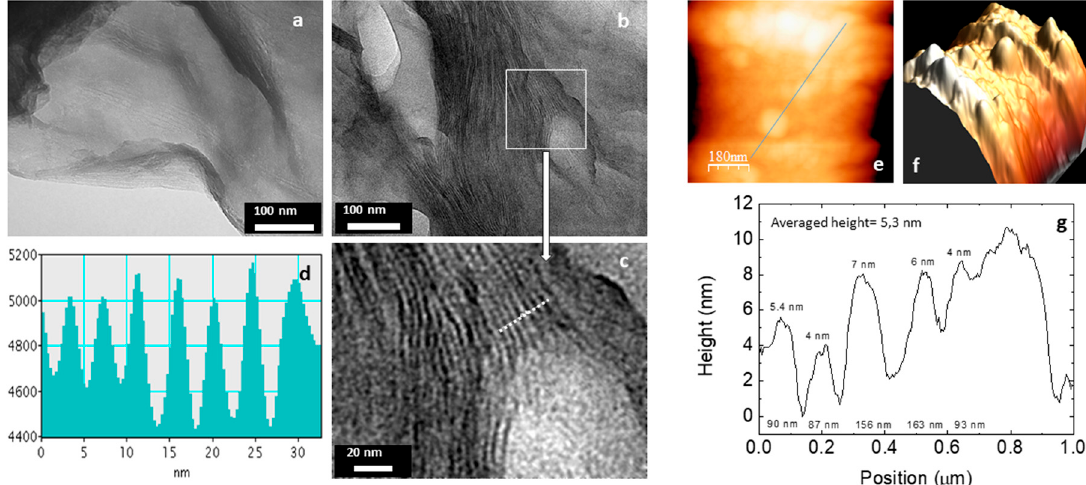
Figure 4. Transmission electron microscopy (TEM) images of ( a ) sample UVM-L18, ( b ) and ( c ) UVM-L18 sample embedded in LR-white resin. ( d ) Line profile of the image intensity of the Si atomic row. Two-dimensional ( e ) and 3D ( f ) Atomic force microscopy (AFM) images of sample UVM-L18. ( g ) Height vs. position along the line indicated in the ( e ) image.